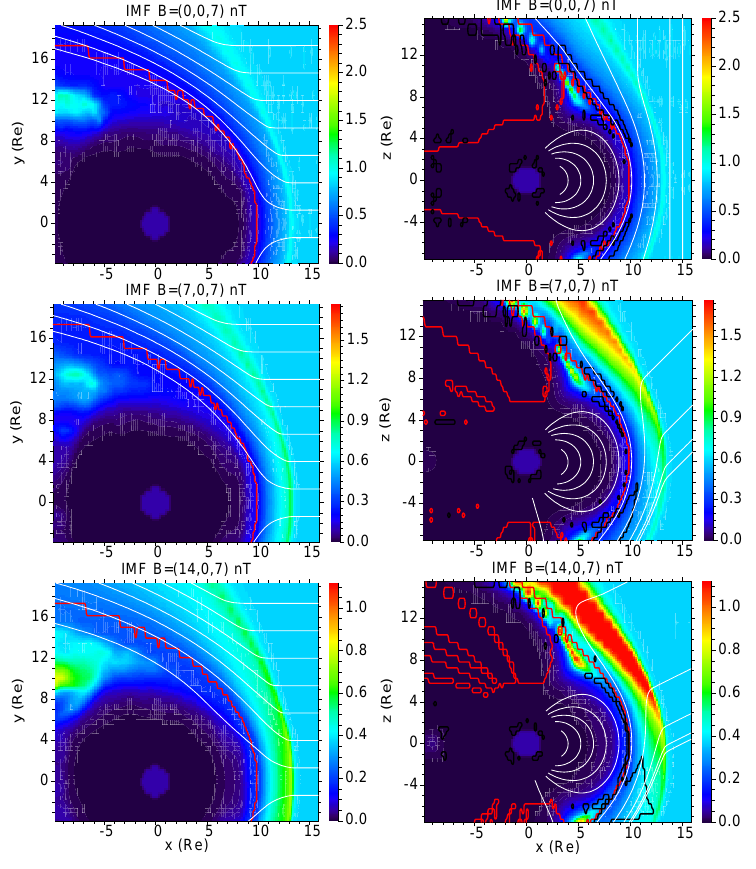
Fig. 7. The dependence of the PDL and the slow mode front on the IMF tilt angle. In these cases, we have the same IMF B y =0nT and B z =7nT, but different IMF B x =0, 7, and 14nT. The other solar wind input parameters are: V =( − 450, 0, 0)km/s, N=6cm − 3 , and T p =T e =10eV. The other formats of this figure are the same as those in Fig.